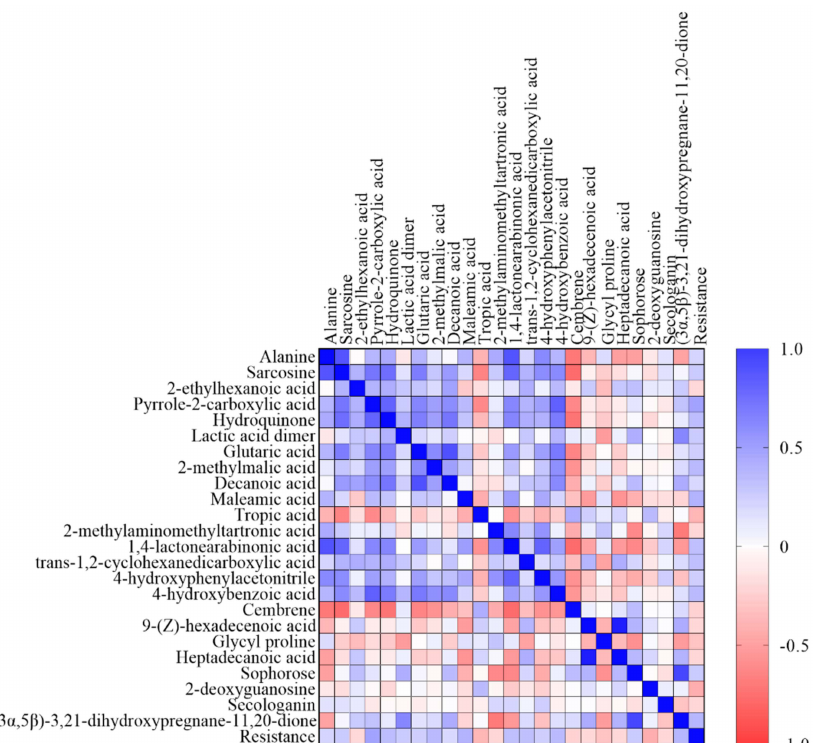
Figure 4. Graphical Spearman correlation matrix of 24 wheat metabolites in grains and varietal resistance to Fusarium . Spearman correlation r values were determined using GraphPad Prism 9.4.1. Colors are added for better visualization. The colors span from dark blue to dark red, where dark blue denotes an r value of 1 and dark red indicates an r value of −